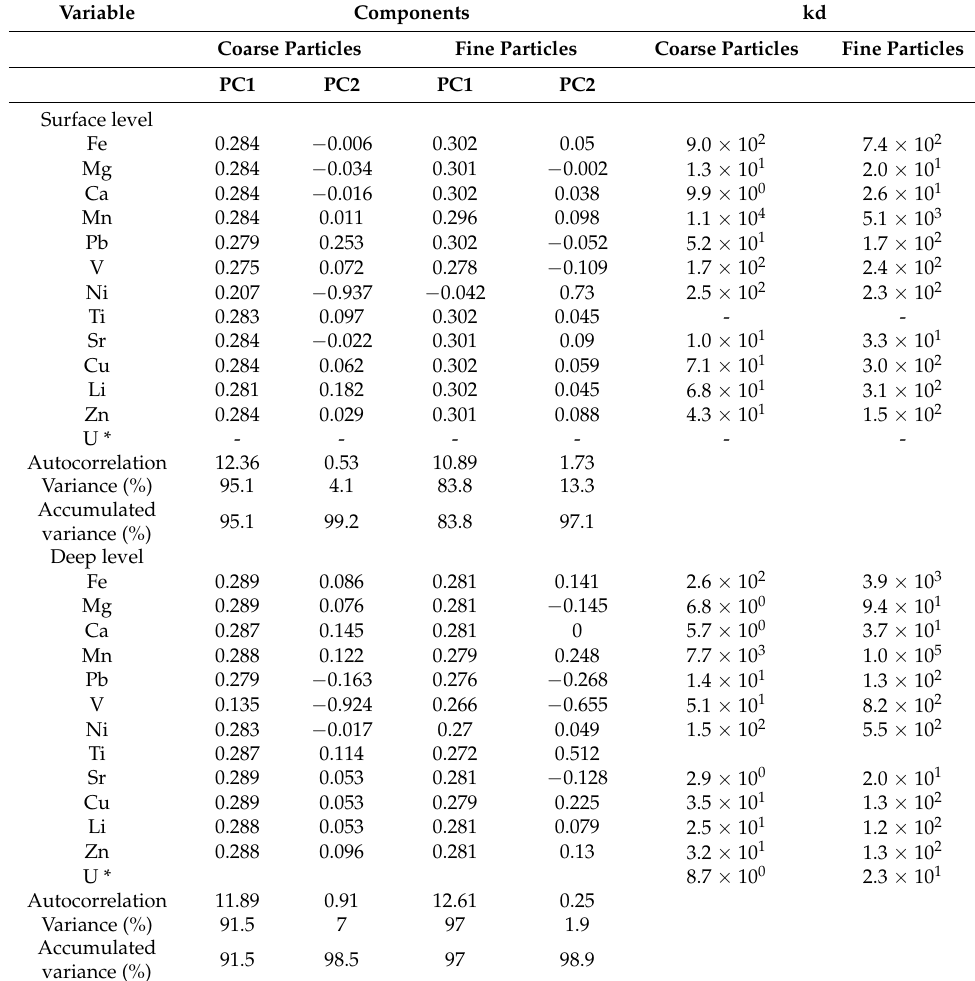
Table 1. Principal component analysis and distribution coefficient (kd; L/kg) of the suspended sediment